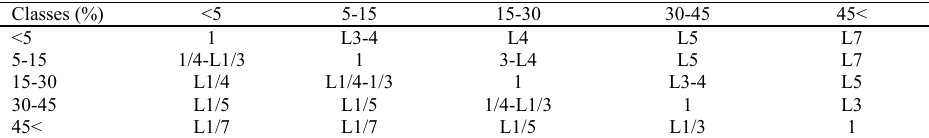
Table 3: Paired comparison matrix and slope classes (Arabsheibani et al., 2016 )